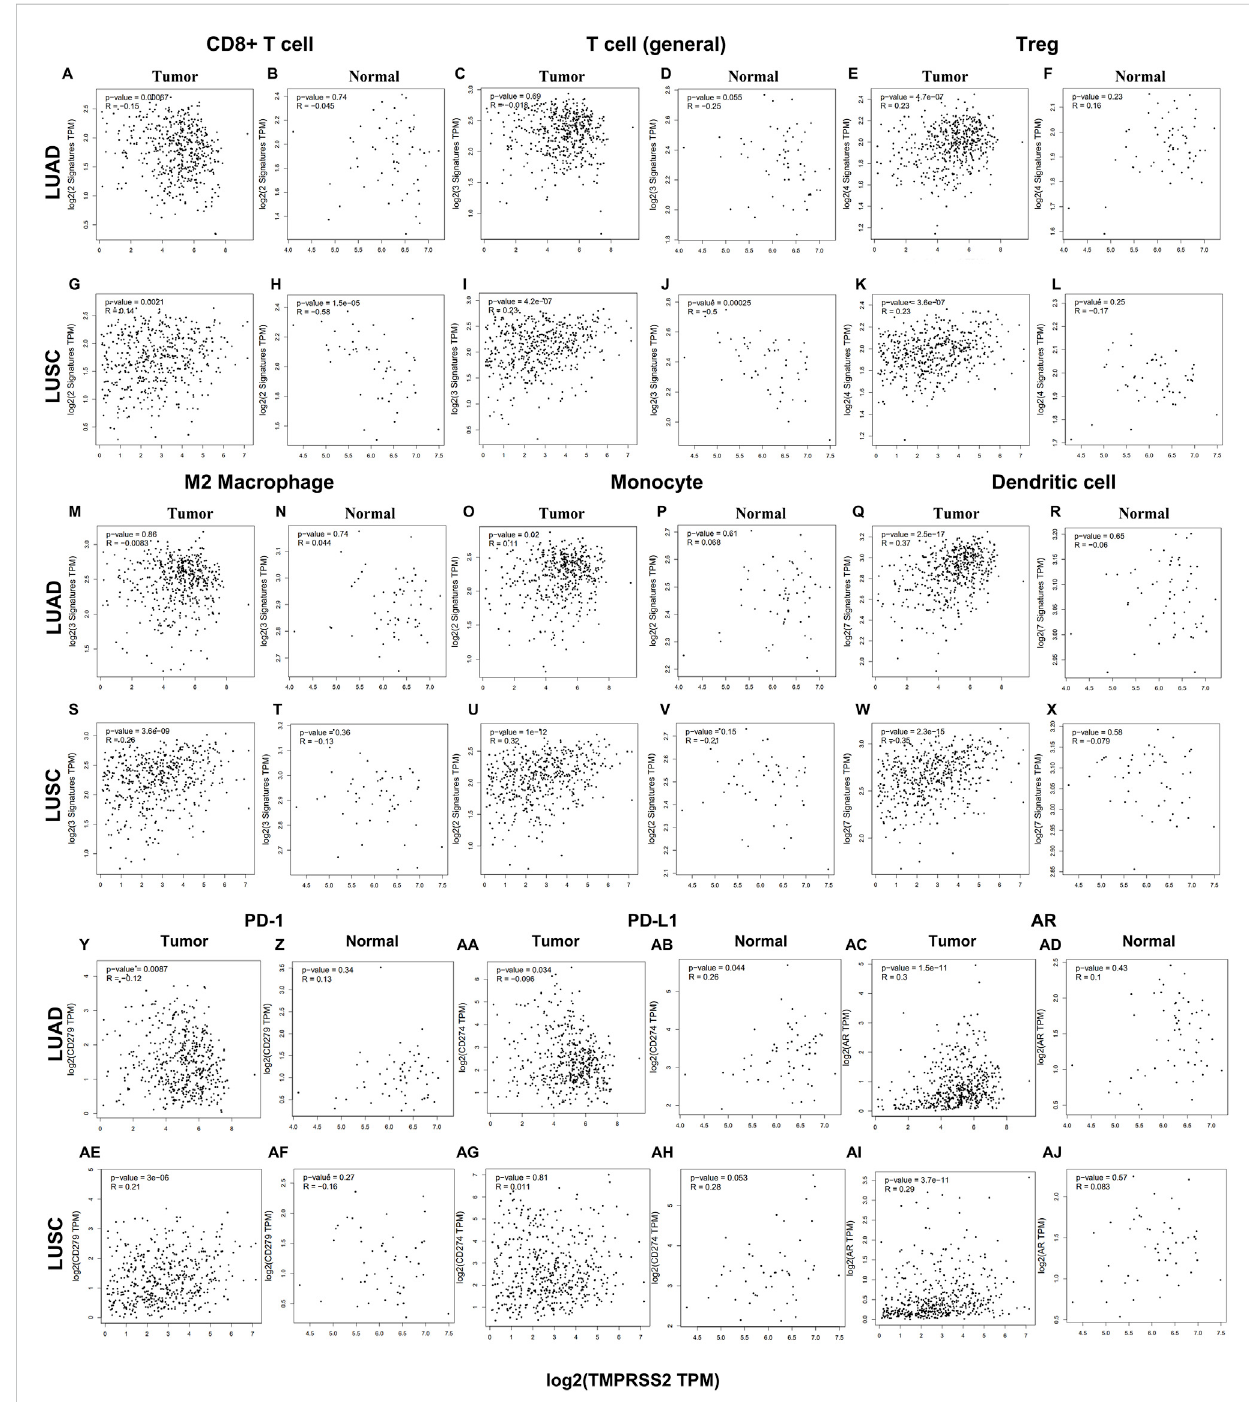
FIGURE 7 Correlation between TMPRSS2 expression and different immune cells in tumor and normal tissue of LUAD and LUSC by using GEPIA2. Markers include general T cell (CD2, CD3D, CD3E); CD8 + T cell (CD8A, CD8B); exhaust-ed T cells (CTLA4, PDCD1, LAG3, GZMB and HAVCR2); Treg (CCR8, FOXP3, TGFB1, and STAT5B); monocytes (CD86, CSF1R); M2 macrophages (VSIG4, MS4A4A, and CD163); Dendritic cell (CD1C, HLA-DPA1, HLA-DPB1, HLA-DQB1, HLA-DRA, ITGAX, and NRP1). Scatterplots of correlations between TMPRSS2 expression and gene markers of CD8 + T cell (A, B) , T cell (general) (C, D) , Treg (E, F) , M2 Macrophage (M, N) , Monocyte (O, P) , Dendritic cell (Q, R) , PD-1 (Y, Z) , PD-L1 (AA, AB) , AR (AC, AD) in tumor and normal tissue of LUAD; Scatterplots of correlations between TMPRSS2 expression and gene markers of CD8 + T cell (G, H) , T cell (general) (I, J) , Treg (K, L) , M2 Macrophage (S, T) , Monocyte (U, V) , Dendritic cell (W, X) , PD-1 (AE, AF) , PD-L1 (AG, AH) , AR (AI, AJ) in tumor and normal tissue of